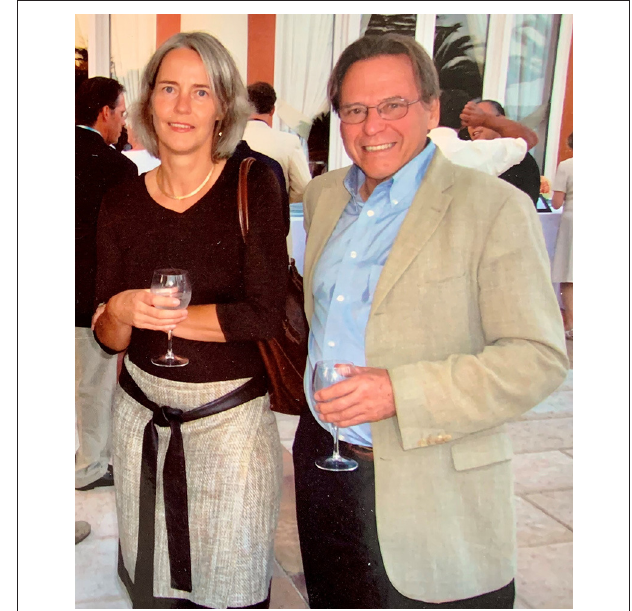
FIGURE 3 | From left to right. Barbara Ludwikowski and Ricardo González. Cocktail in an international